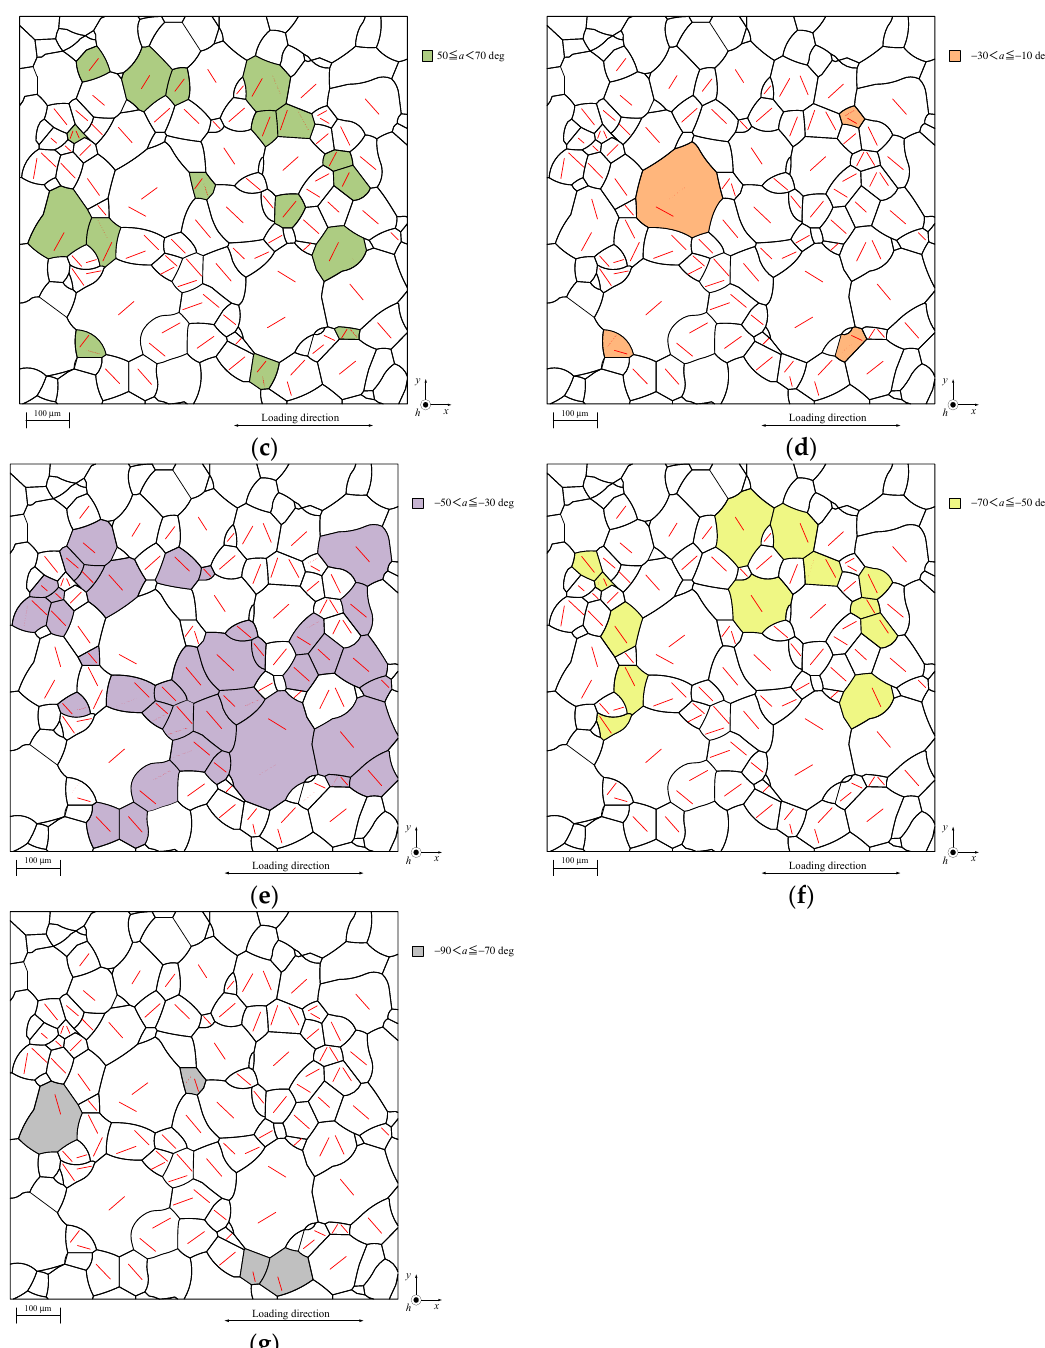
Figure 8. Distribution of grains with similar slip-line directions. ( a ) 10° ≤ θ < 30°; ( b ) 30° ≤ θ < 50°; ( c ) 50° ≤ θ < 70°; ( d ) − 10° ≤ θ < − 30°; ( e ) − 30° ≤ θ < − 50°; ( f ) − 50° ≤ θ < − 70°; and ( g ) − 70° ≤ θ < − 90°.